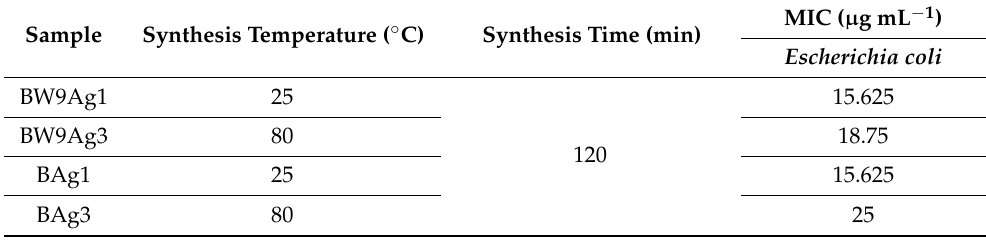
Table 7. Minimum inhibitory concentration (MIC) of BW9 and B nanocomposites for E. coli